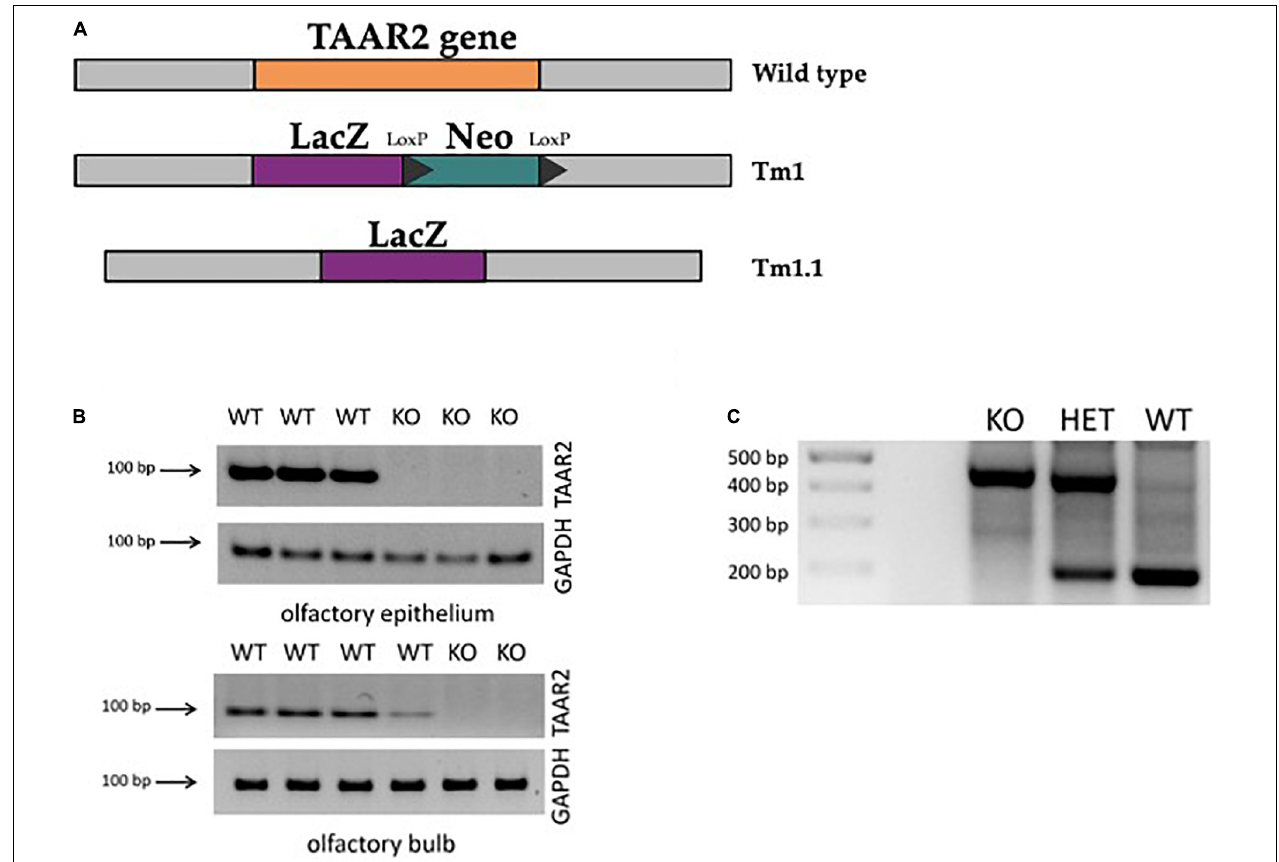
FIGURE 1 | | Generation of trace amine-associated receptor 2 knockout (TAAR2-KO) mice. (A) TAAR2-KO mice were generated using homologous recombination with ZEN-Ub1 vector, which resulted in the deletion of the TAAR2 gene (Gene ID: 209512, MGI:2685071), and insertion of expression-selection cassette that contained LacZ (beta-galactosidase cording sequence from Escherichia coli LacZ gene) and Neo (cording sequence of neomycin) (Tm1) following Cre-mediated excision which resulted in the removal of the neomycin selection cassette leaving the inserted lacZ reporter sequence (Tm1.1). (B) The knockout of the TAAR2 gene was further confirmed by RT-PCR, in which the presence of TAAR2 mRNA was detected in the olfactory epithelium and olfactory bulb of the WT mice, but not in TAAR2 knockout mice. (C) Standard genotyping of TAAR2 knockout mice: genomic DNA was obtained from animal skin tissue of WT, TAAR2-HET, and TAAR2-KO mice. Knockout gene showed 400 bp band, wild-type gene showed 200 bp